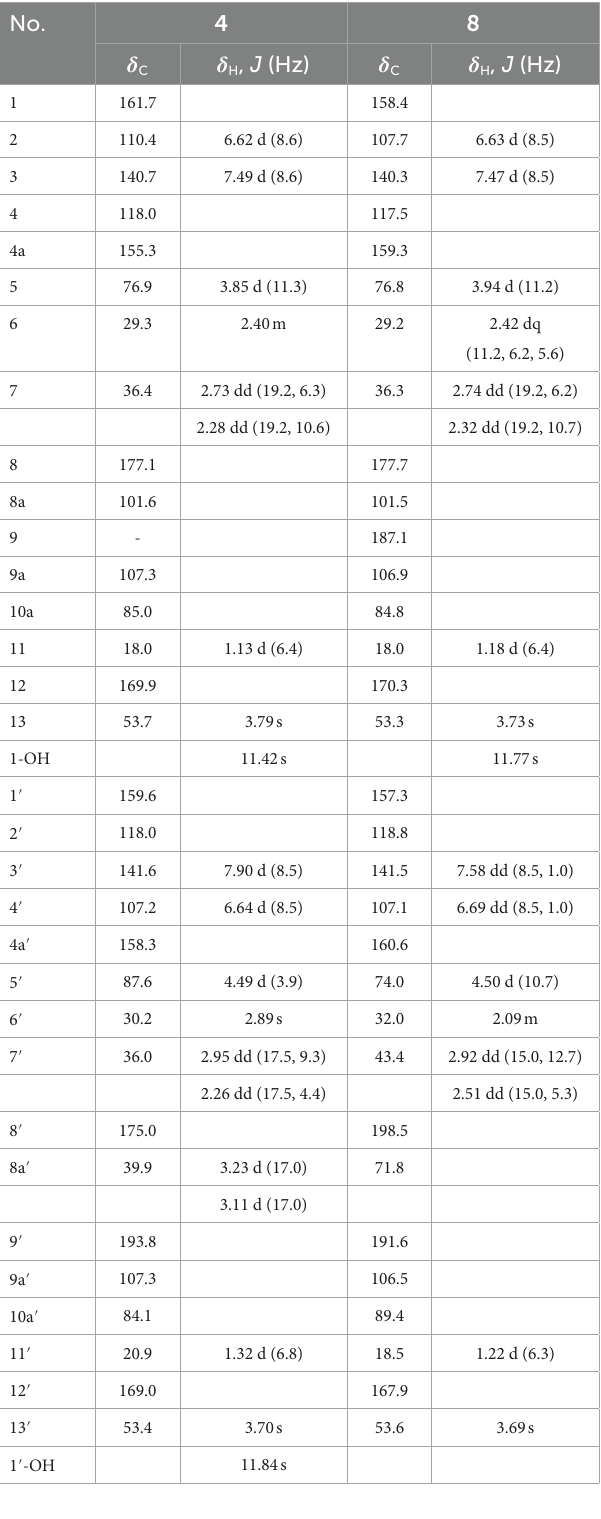
TABLE 1 1 H and 13 C NMR spectroscopic data for 4 and 8 (CDCl 3 , TMS, δ